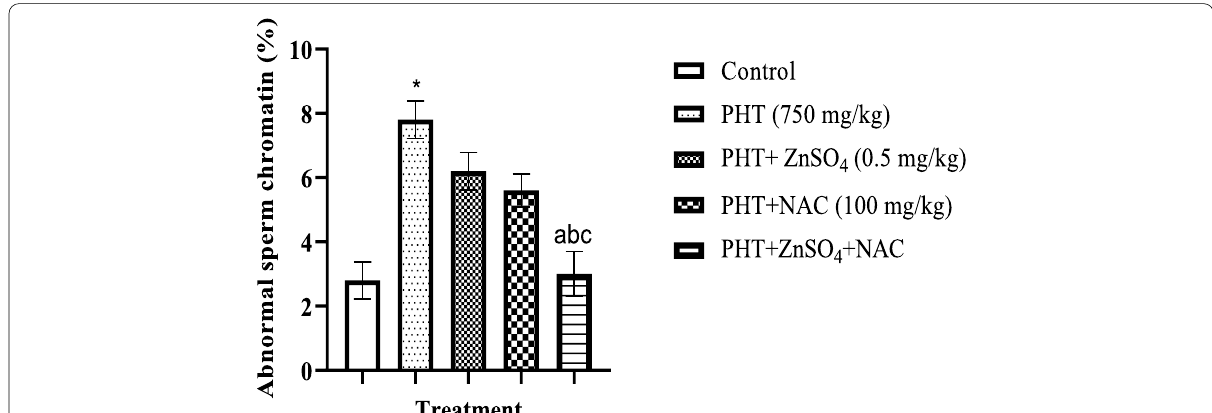
Fig. 4 Effect of treatment with zinc sulfate and N‑acetylcysteine on abnormal sperm chromatin condensation in phthalate‑treated male Wistar rats. Values are expressed as mean SEM ( n 5) ( p < 0.05 ) (one‑way ANOVA followed by Tukey’s post hoc test). n ± = sulfate, NAC N‑acetylcysteine. *, a , b , and c were considered statistically significant when compared with the control, PHT‑, PHT PHT NAC‑treated groups +